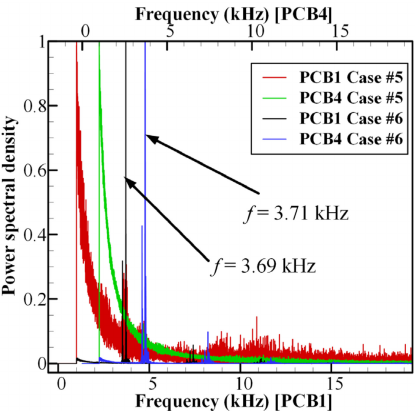
Figure 15. Local view of dynamic high-frequency distribution for Cases #5 and #6.